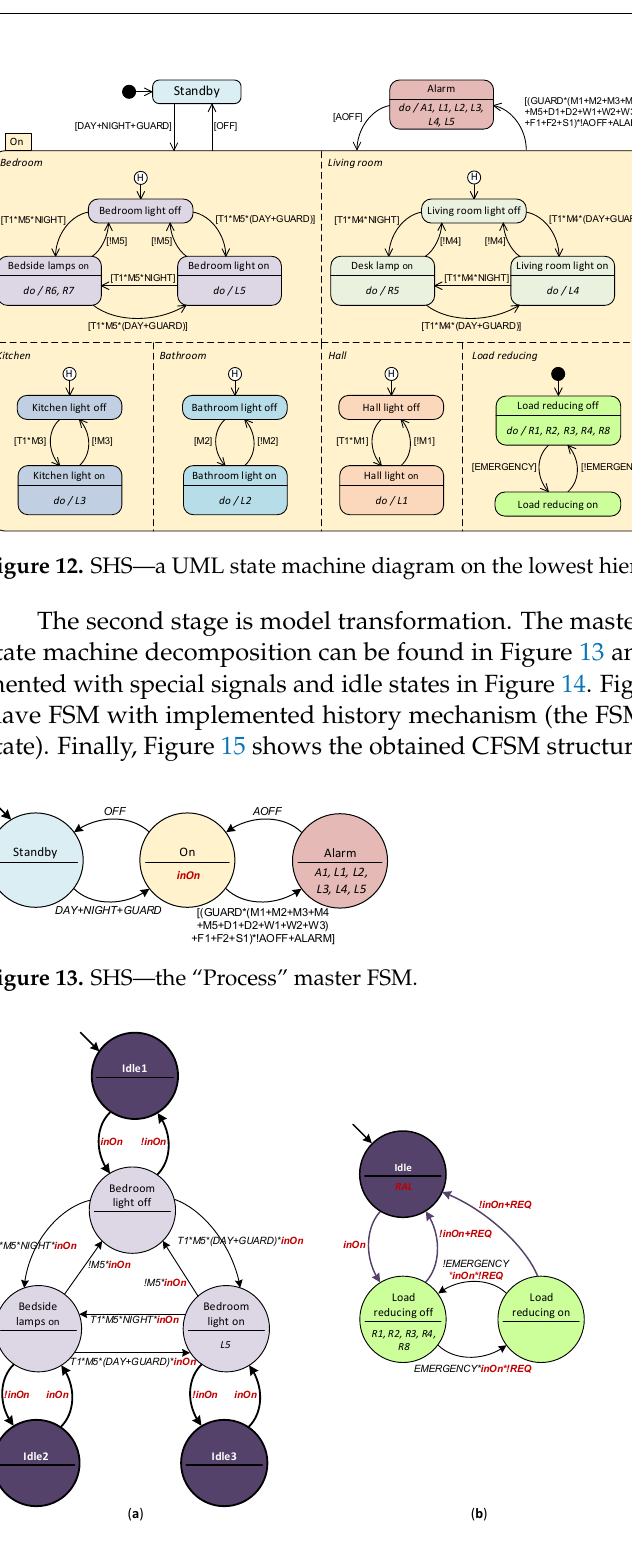
Figure 11. SHS—a UML state machine diagram on the highest hierarchy level.